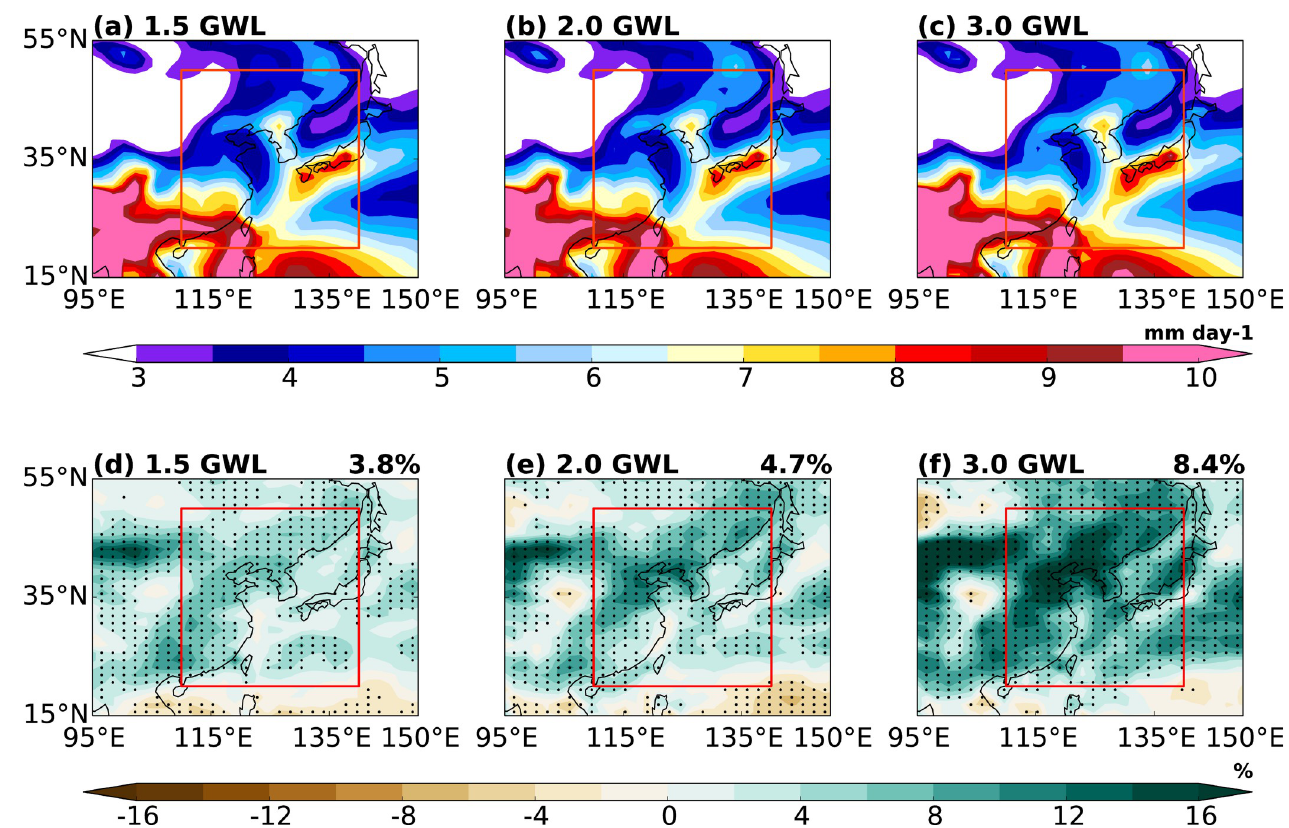
Fig 6. Spatial distributions of future EASM under (a) 1.5˚C, (b) 2.0˚C, and (c) 3.0˚C levels of global warming and (d, e, f) difference of each warming level relative to the PD period. Dotted area indicates significance at 95% confidence